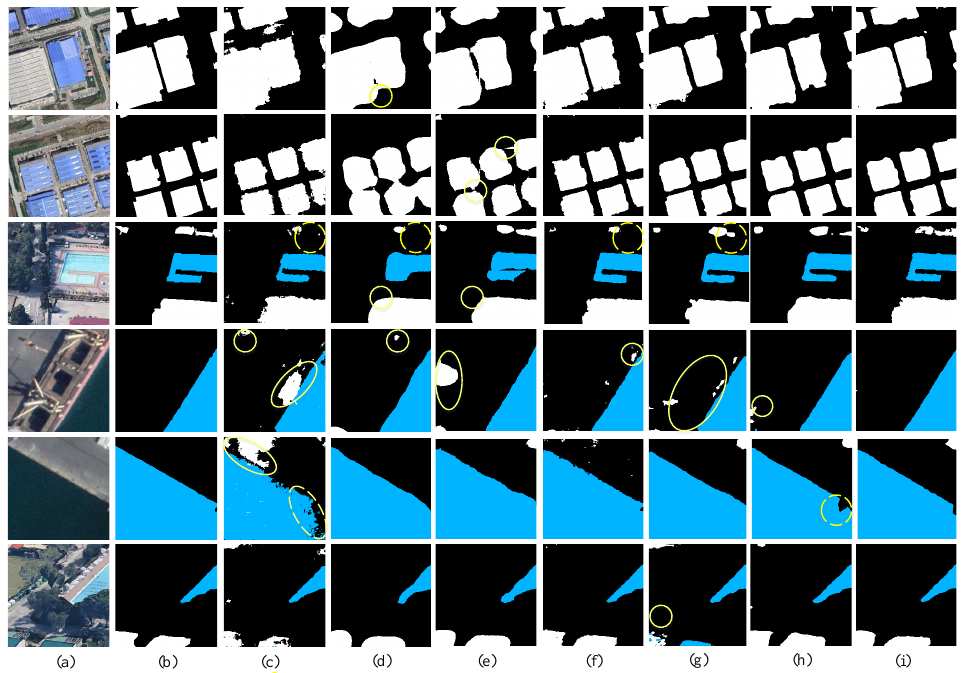
Figure 11. Comparison of the actual segmentation results. ( a ) Real image; ( b ) label; ( c )